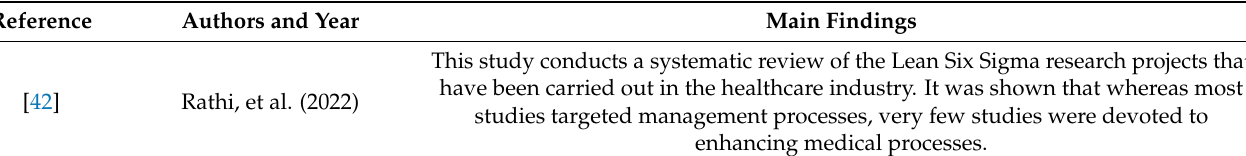
Table 1. Lean tools in healthcare in developing